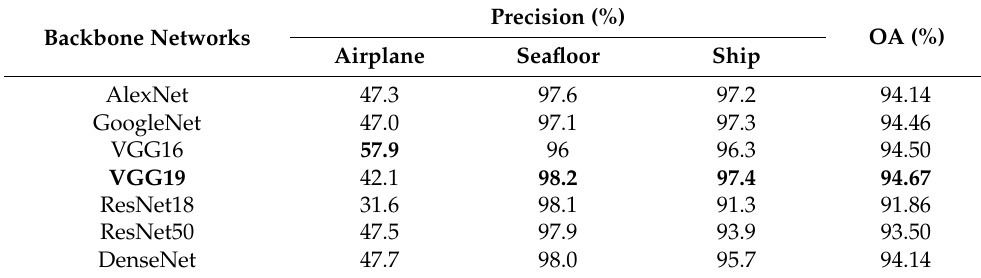
Table 3. Comparison of different fine-tuning backbones for the classification of SSS